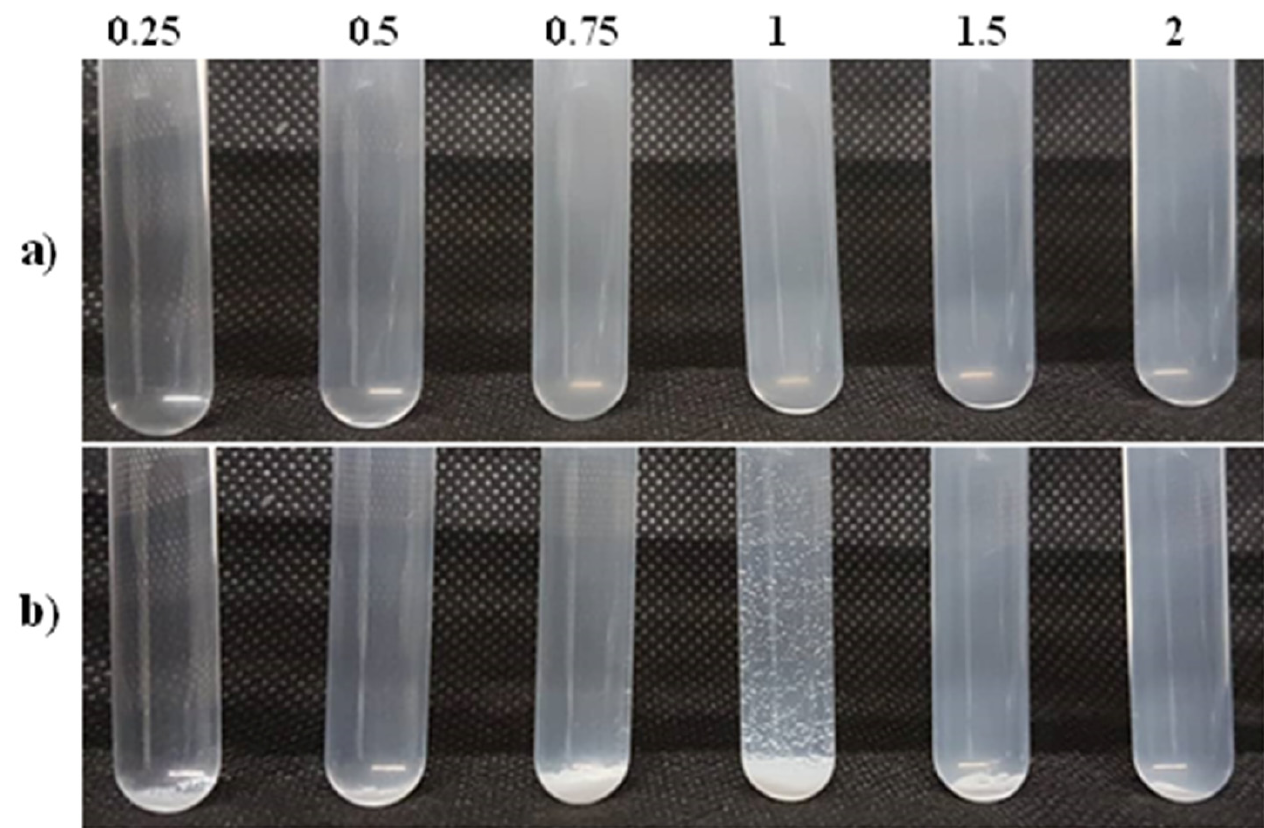
Figure 5. Optical aspect of the PEC dispersions formed by rapid addition of PDADMAC into PSS100% at various molar charge ratios Z(+/ − ), between 0.25 and 2. ( a ) immediately after mixing; ( b ) after five days.